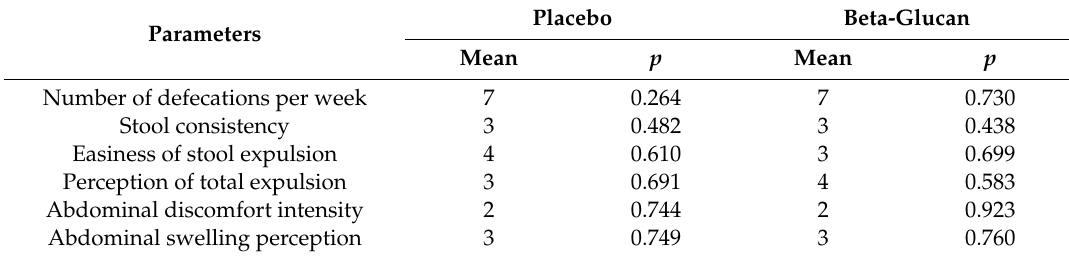
Table 6. Pre-versus post-treatment e ff ects on intestinal function of the tested